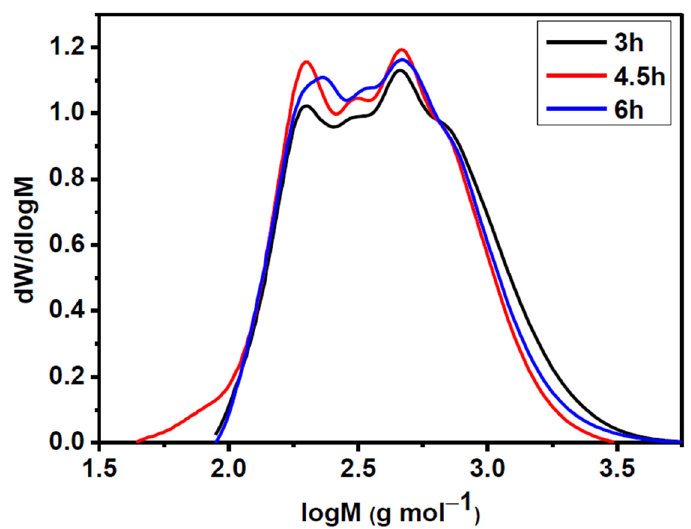
Figure 12. The effect of time of spruce wood RCF over the Ru/C catalyst at 225 °C for 3 h on the molecular weight distribution of the liquid products.